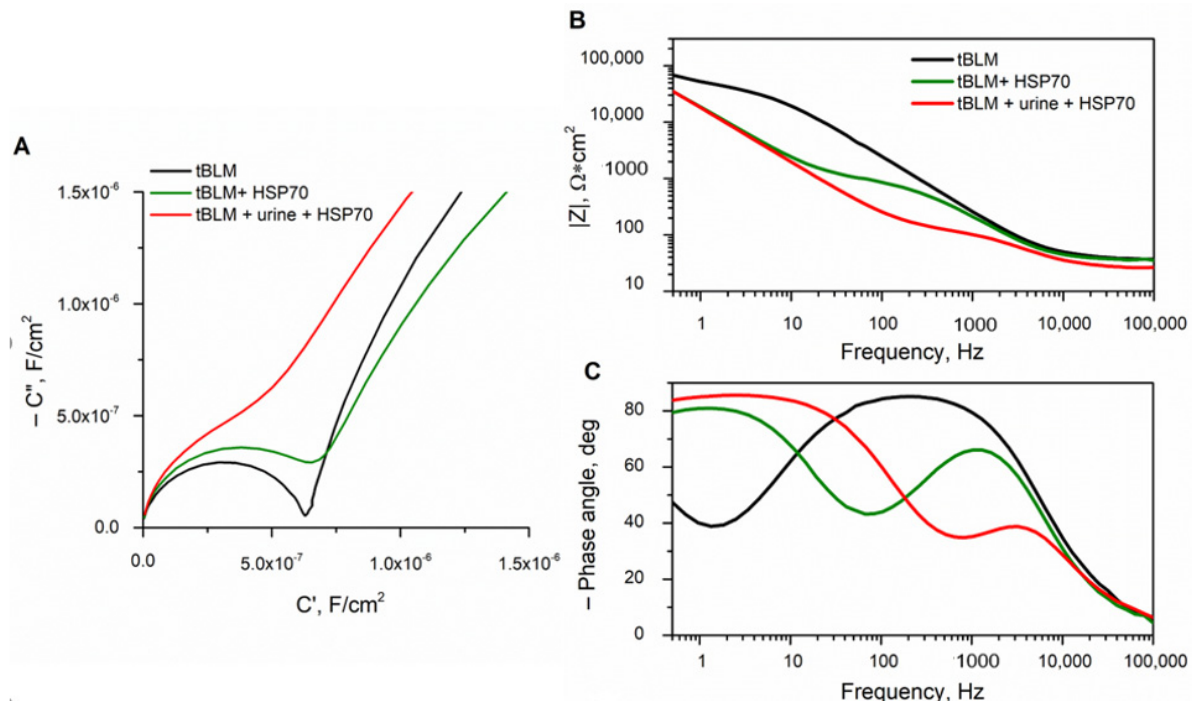
Figure 6. Comparison of the impact of HSP70 on tBLM in urine (red) and buffer (green) media: ( A ) The Cole–Cole plot of complex capacitance. Spectra is enlarged high-frequency part of the spectrum. The curves refer to the same Bode spectra as in B and C; ( B ) impedance magnitude vs. frequency (Bode) plots; and ( C ) impedance phase vs. frequency (Bode) plots. tBLMs were completed with the DOPC : CHO (in ratio % 60:40) phospholipid mixture. HSP concentration was kept 0.05 µ M. The sample size for this experiment was n = 12.